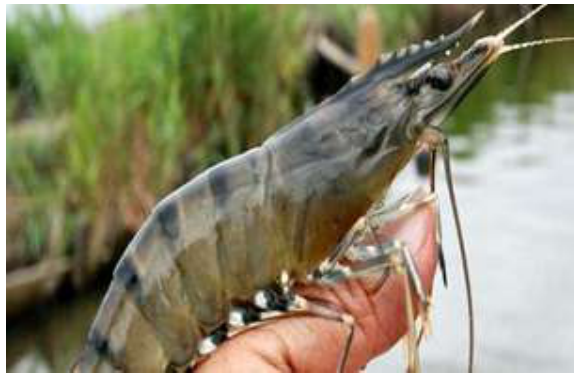
Figure 7. Shrimp (Bagda) culture activities